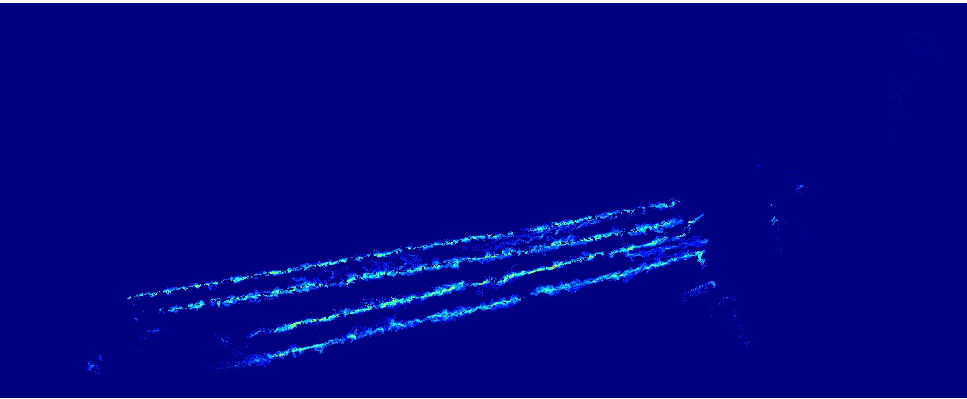
Figure 7. ( a , b ) Top-view images, based on the Jet colour-array, representing the volume of the vineyard segment. Colder or hotter colours mean lower and higher volumes,